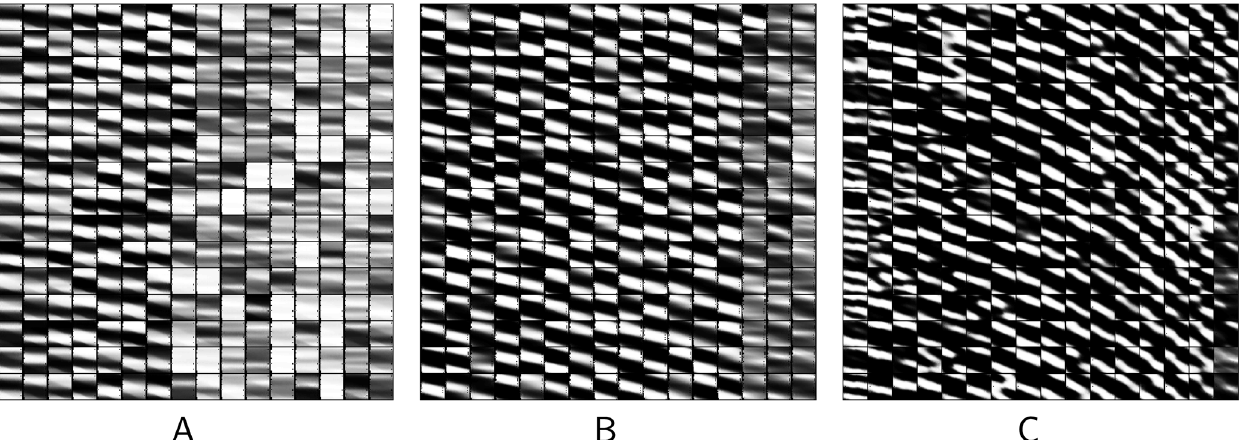
Fig 7. Emergence of position and velocity receptive during training. Velocity tuning takes longer to emerge than position tuning, because velocity information is only available in the inputs after position has already been learned by the hidden units — and subsequently fed back. (A) After 100 batches of training, stripes are mostly horizontal or very shallowly sloped in position-velocity space — no velocity tuning. (B) By 200 batches, velocity tuning is evident across most units. (C) Later, at 1000 batches, the slopes of the “ stripes ” have increased, indicating position tuning for more temporally distant (past) stimuli.